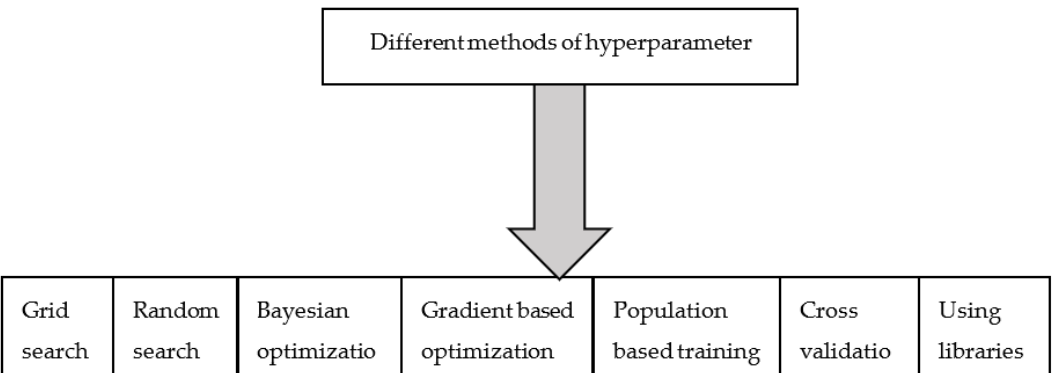
Figure 15. Different Hyperparameter tuning